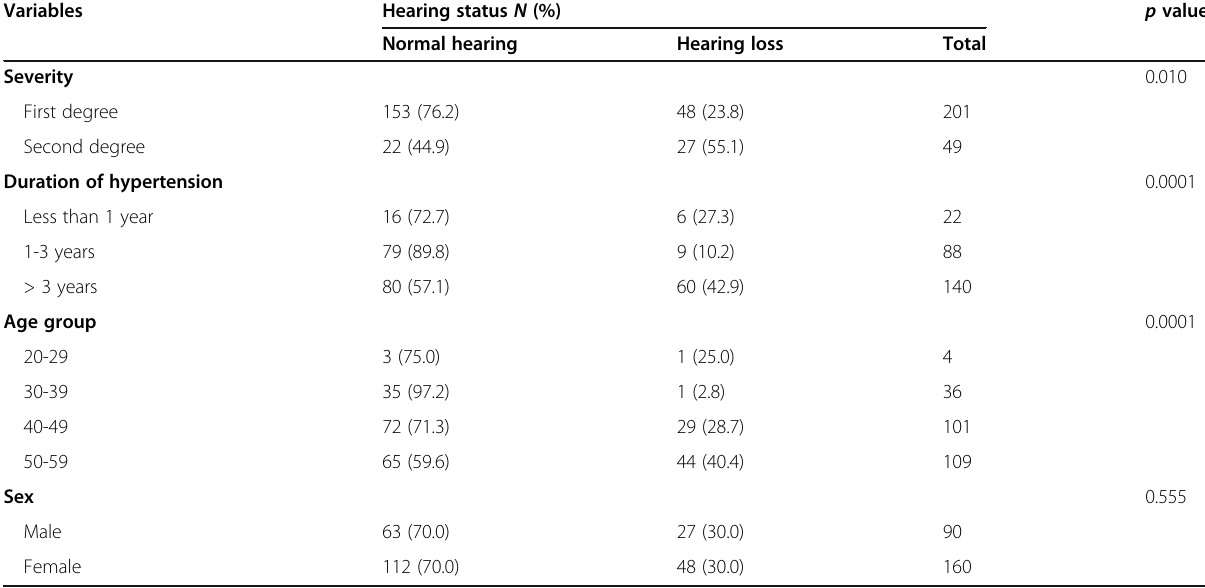
Table 3 Association between age, gender, severity, and duration of hypertension with hearing status among subjects Variables Hearing status N (%)